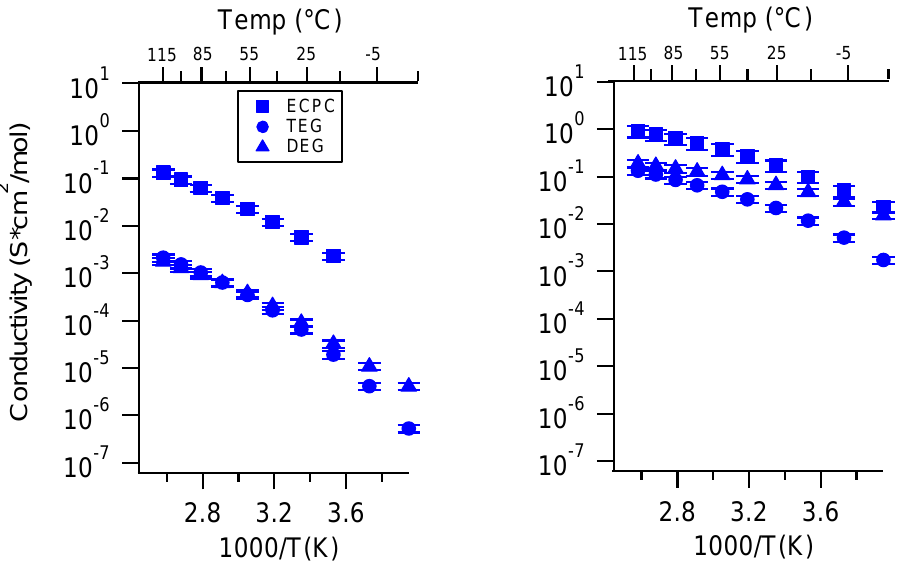
Figure A32. Molar Conductivity as a function of solvent for PEGDMA1000_med_SSM (left) and PTHFDA1000_med_STFSIM (right) SIPEs. Temperatures ranged from − 20 ◦ C to 115 ◦ C. Compare to Figure A27.